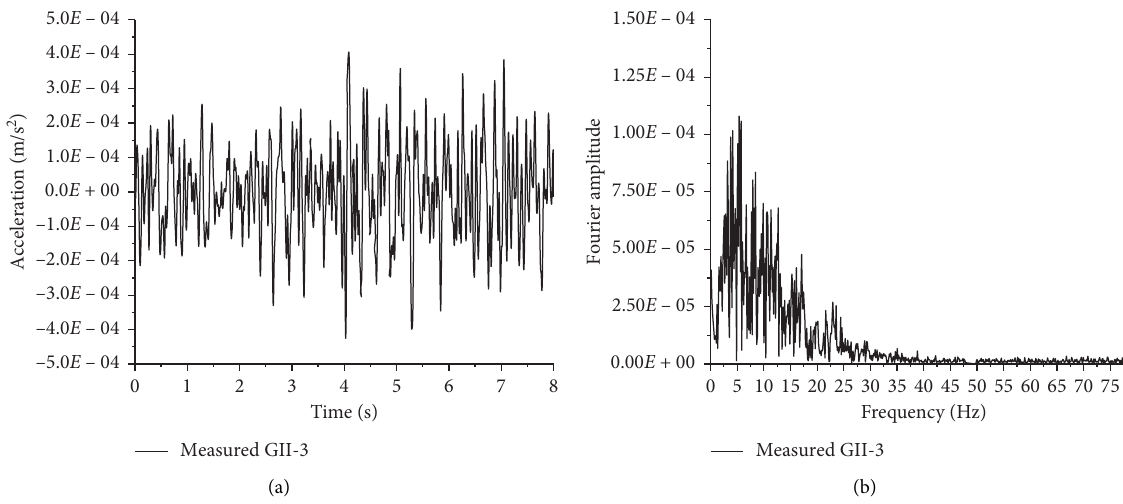
Figure 12: Acceleration: (a) time history and (b) frequency spectrum of